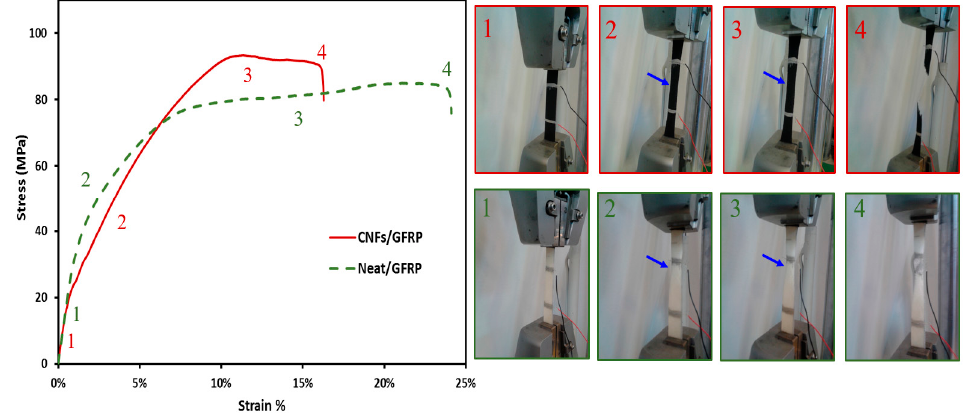
Figure 10. Typical stress-strain curves of neat glass fiber composite and GFRP incorporating 2.0% CNFs. Right-hand-side photos show test instances and corresponding values on stress-strain.